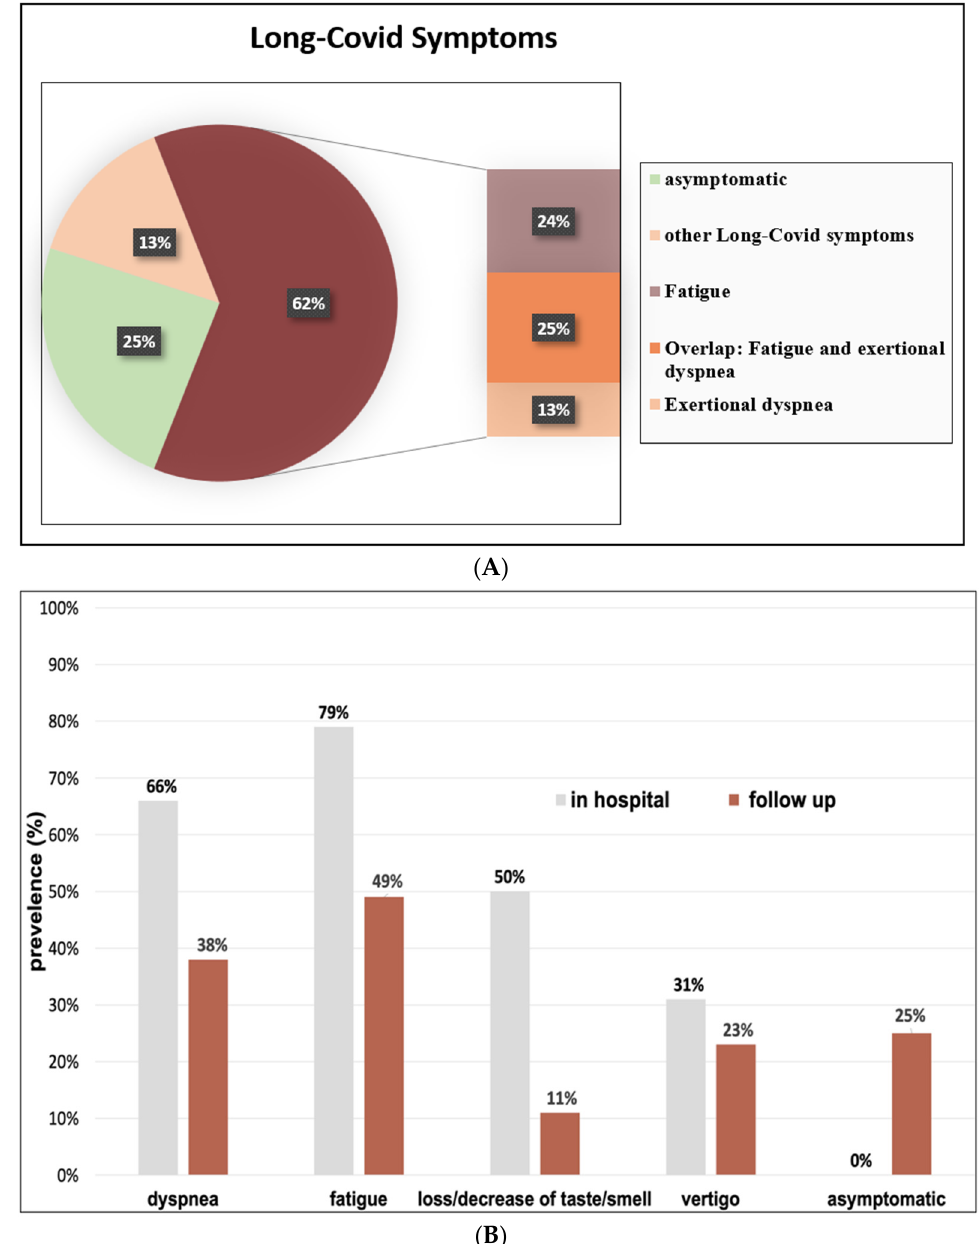
Figure 3. ( A ) Spectrum of Long-COVID symptoms 6 months post discharge. ( B ) Spectrum of Long-COVID symptoms 6 months post discharge in relation to acute phase symptoms during hospital stay. All symptoms decreased in frequency over time (Figure